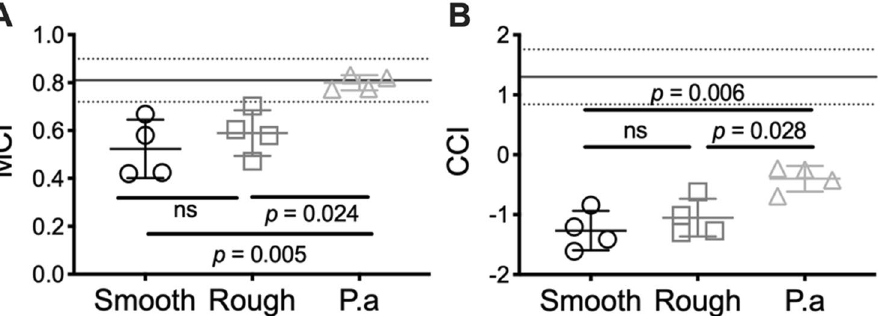
Figure 5. M. abscessus colony-biofilms have reduced theoretical mucociliary and cough clearance index. (A) Mucociliary and (B) cough clearance index of 4-day M. abscessus and P. aeruginosa (P.a) colony-biofilms. Lines at (A) and (B) are the MCI (0.81 ± 0.09) and CCI (1.3 ± 0.46), respectively, of sputum collected from patients with CF, previously determined by 54 . N = 4; data presented as individual data points with mean ± SD. Statistical analysis was performed using a one-way ANOVA with a Tukey’s post-hoc test; ns indicates not